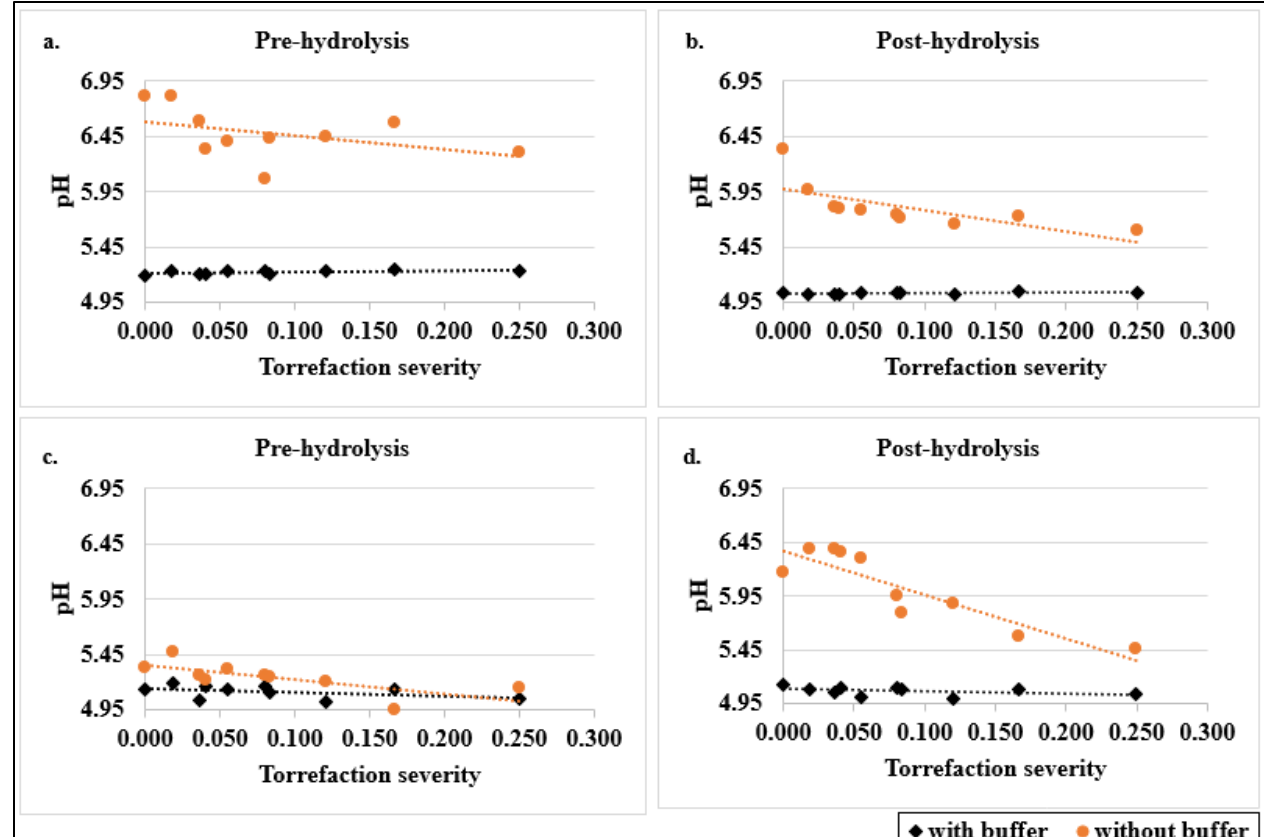
Figure 3. pH of the buffered and unbuffered suspension before and after enzymatic hydrolysis with torrefied biomass at various levels without alkaline pretreatment ( a , b ) and with alkaline pretreatment before torrefaction ( c , d ).